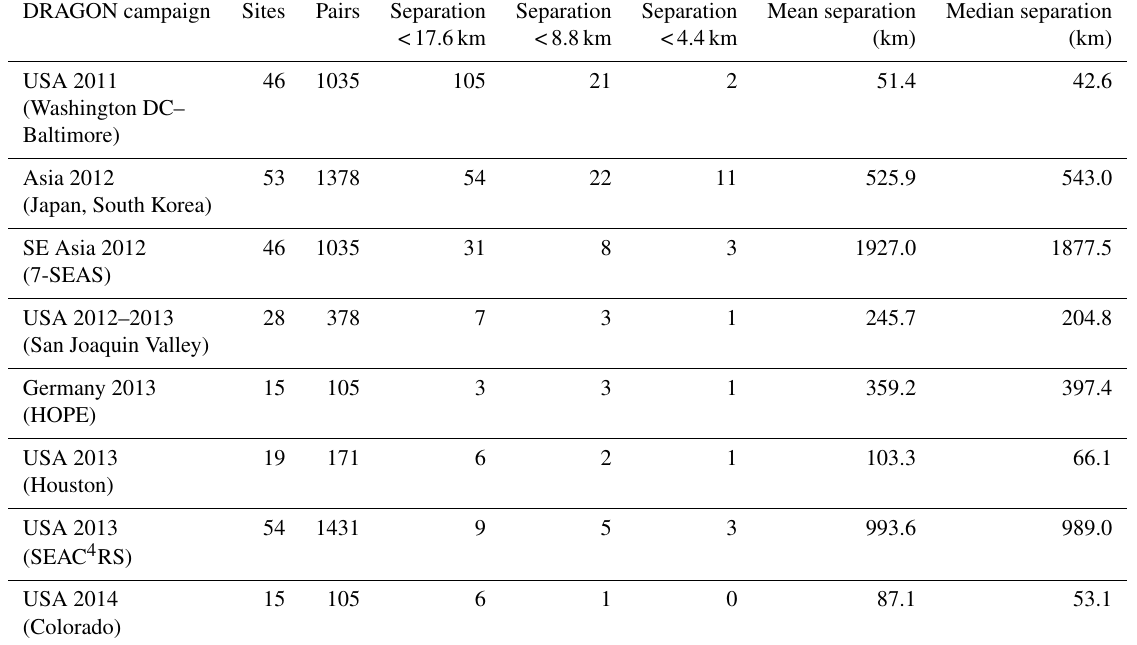
Table 1. Spatial statistics of AERONET-DRAGON deployments. DRAGON campaign Sites Pairs Separation Separation Separation Mean separation Median separation <17.6km <8.8km <4.4km (km) (km) USA 2011 46 1035 105 21